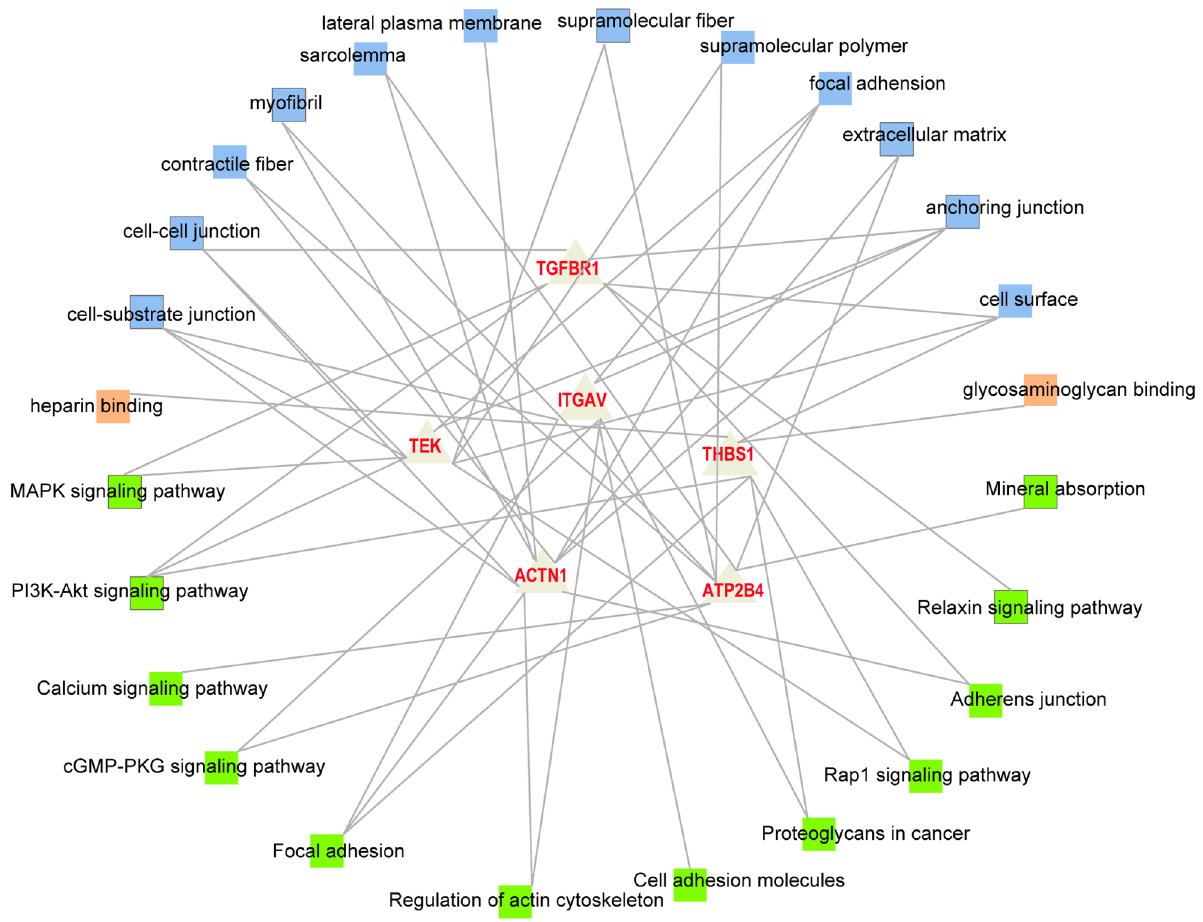
Figure 3. The network diagram of the novel candidate genes affecting the WHC and their belonged GO terms and pathways. Blue and orange squares represent the enriched GO terms. Green squares represent the enriched pathways.